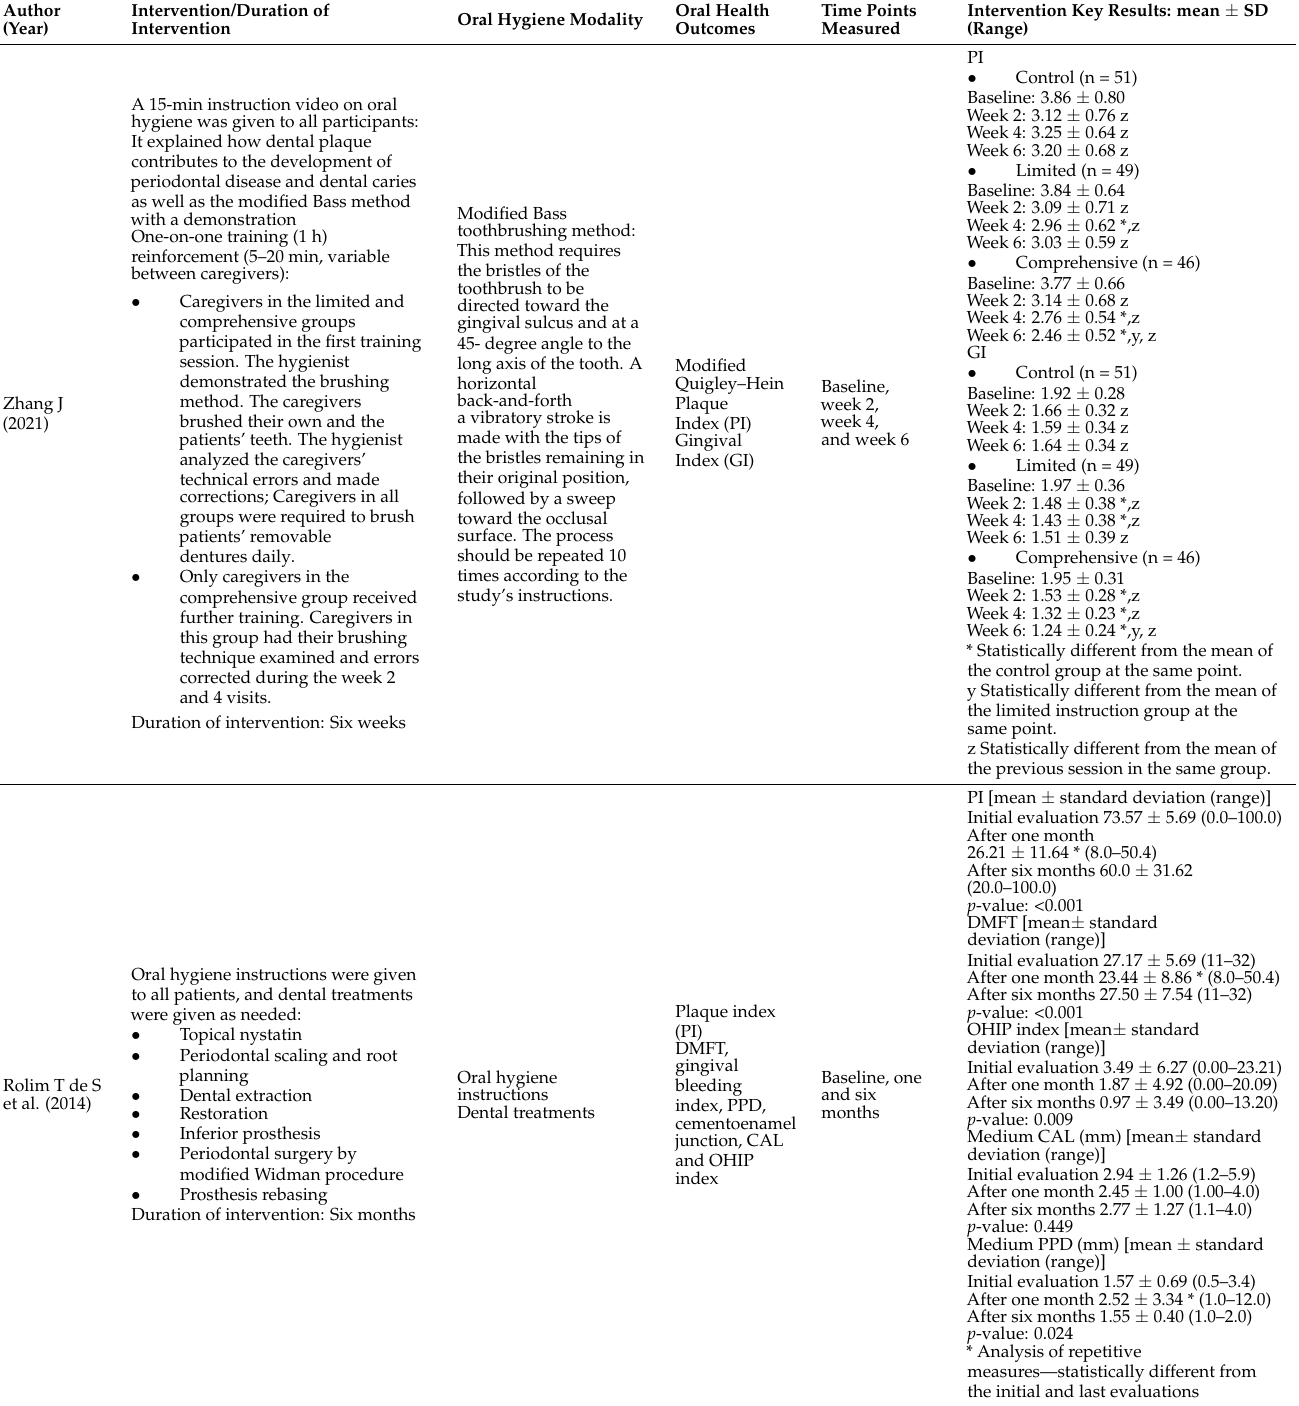
Table 2. Results of the studies included on oral health care interventions in patients with Alzheimer’s disease.